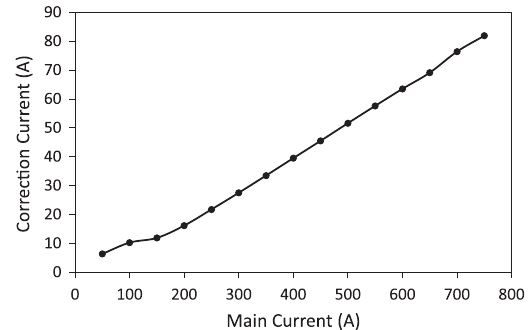
FIG. 12. Dependence of the corrector coil current on the main coil current for the SCU0.